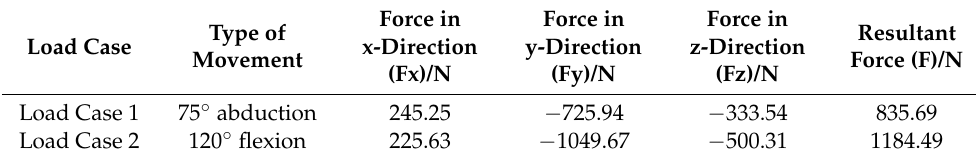
Table 1. The two load cases used in the FEA model. The values for resultant forces and x, y, and z components are given.